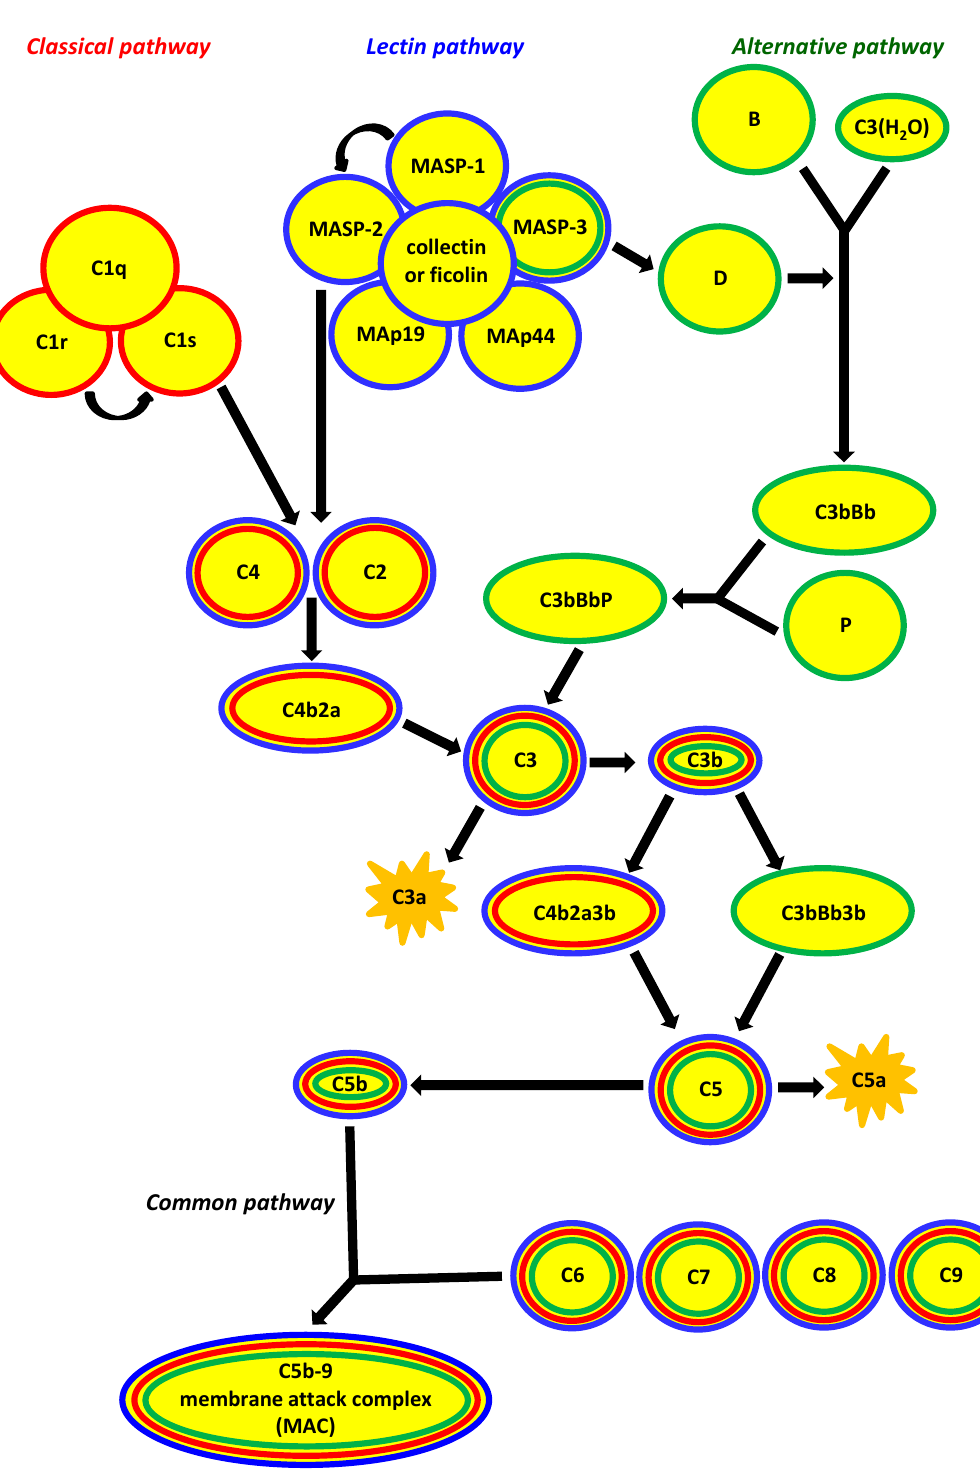
Figure 1. The three major pathways of complement activation. They differ crucially in their initiating events: the classical pathway depends on antibody recognition and binding to C1q; the alternative pathway depends on low-level spontaneous hydrolysis of C3 being stabilised by bacterial polysaccharides, etc.; and the lectin pathway depends on the recognition of polysaccharides/glycoconjugates by collectins (mannose-binding lectin (MBL), CL-10, CL-11) and ficolins (ficolin-1, ficolin-2, ficolin-3). The common result is the generation of C3b from C3; the classical and lectin pathways produce C4b2a as the C3 convertase, whereas that role is played by